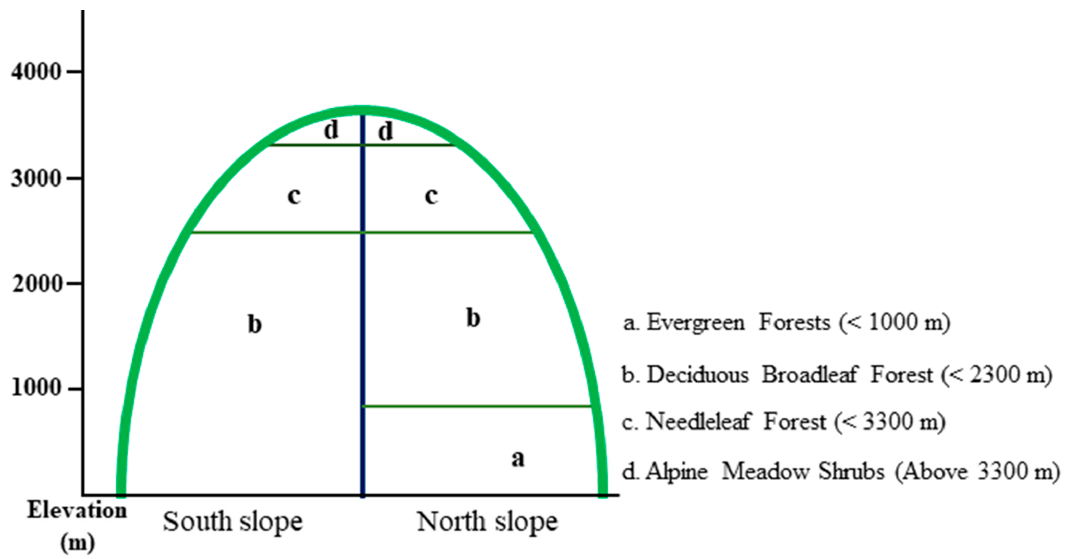
Figure 3. Vertical distribution of forest types in the study area.